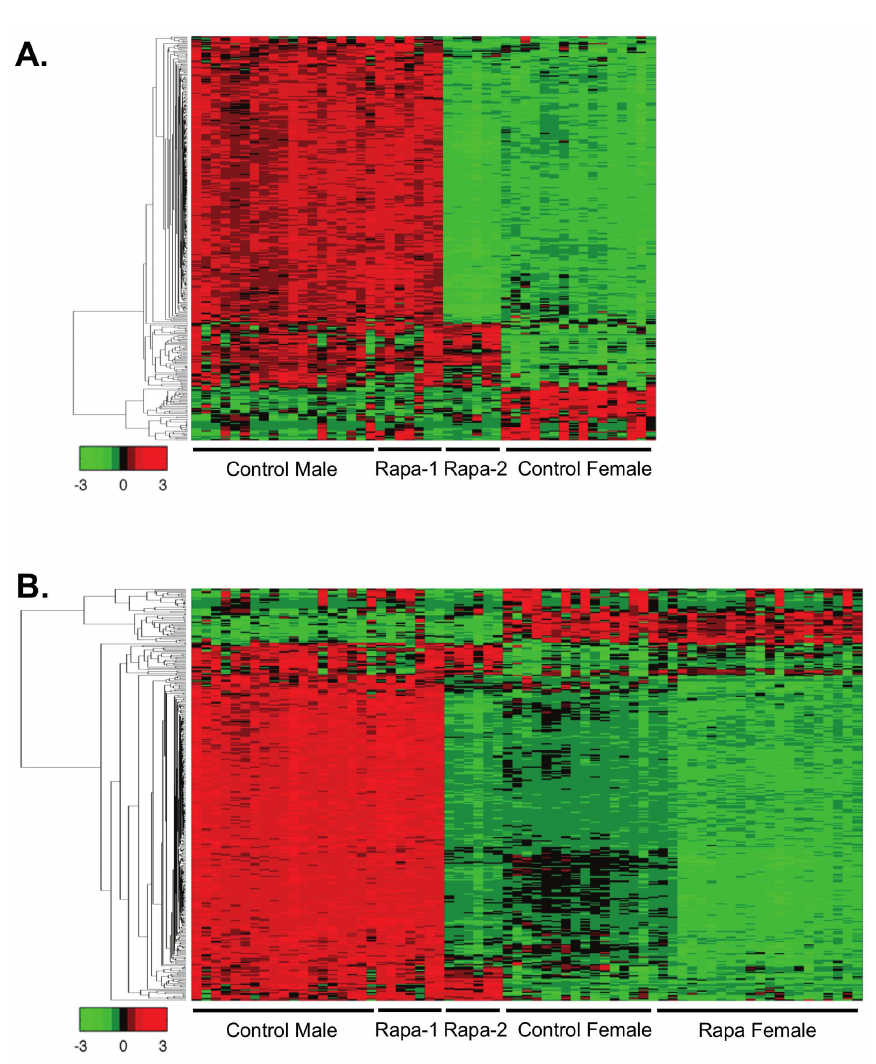
Figure 4. Heatmap analysis of the transcriptome for gender differences. We identified the 372 transcripts (333 higher in males and 39 higher in females that were significantly different in control male and female 25-month-old mice using a filtering criteria of adjusted p-value , 0.01 and log2 change greater than 1 or 2 1. The expression of these transcripts are shown in a heatmap analysis format for Control male, Rapa-1 male, Rapa-2 male, and Control female mice ( A ). The differences in the gender specific transcripts highlight that Rapa-2 male mice are different from control and Rapa-1 male and that the changes appear similar to the females. However when Rapa female mice is added to the heatmap analysis, it appears that the gender specific transcripts in Rapa-2 male are actually more similar to the Rapa female mice ( B ). The genes were clustered using linkage hierarchical cluster with Euclidean distance, and the expression of each of the transcripts are shown with red for high, black for middle, and green for low